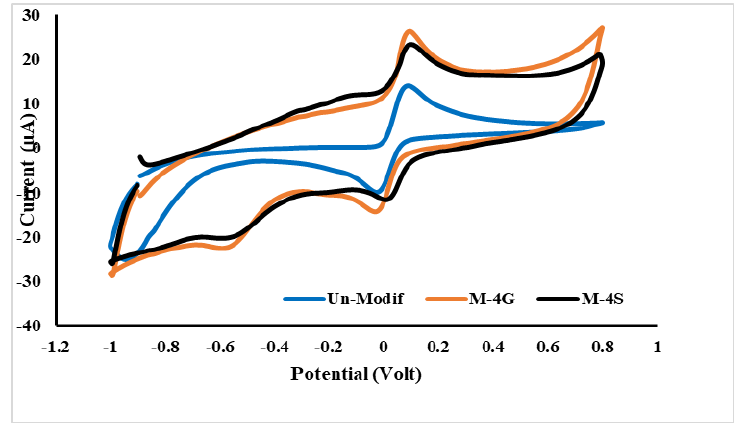
Figure 3. Voltammograms of cyclic voltammetry for p -AP solution in pH 6.2 buffer on SPCE-un-